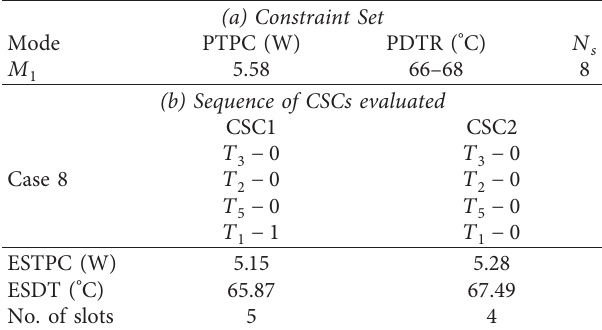
Figure 17: RTSA using Explorer for cases 7 and 8. (a) Selected system configuration for case 7. (b) Selected system configuration for case 8. Table 12: Constraint Set and CSCs evaluated for case